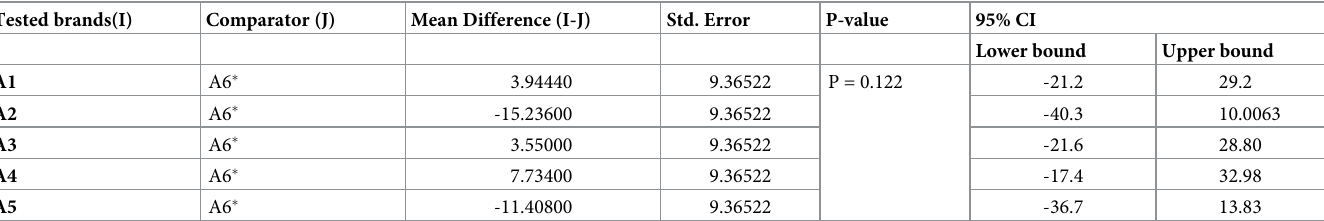
Table 11. Dunnett multiple comparisons test for dissolution profile of azithromycin tablets tested with comparator. Tested brands(I)